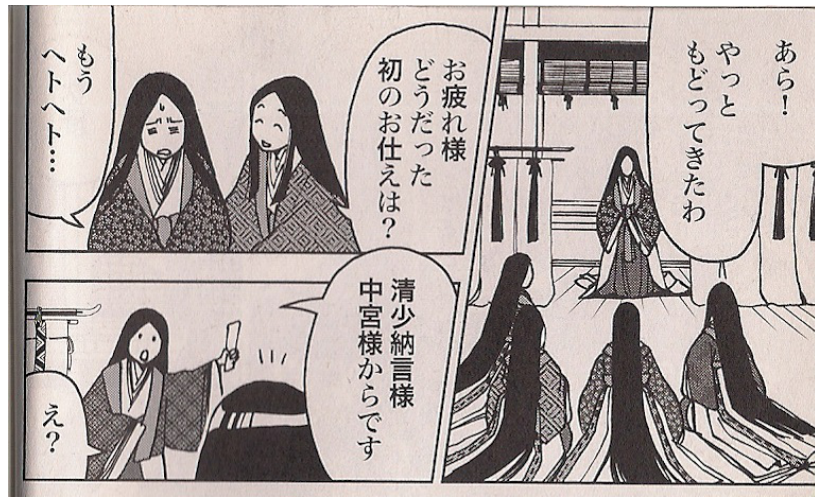
Figure 4. Sei appears as a diligent employee. Variety Art Works, Makura no sōshi , Manga de dokuha (2011), 22. (Courtesy of Īsuto